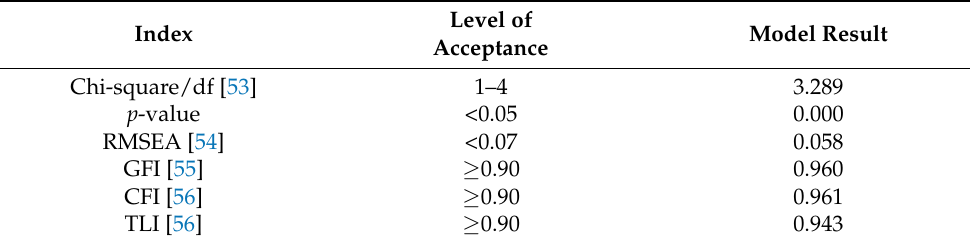
Table 10. Recommended fitness index and results of the